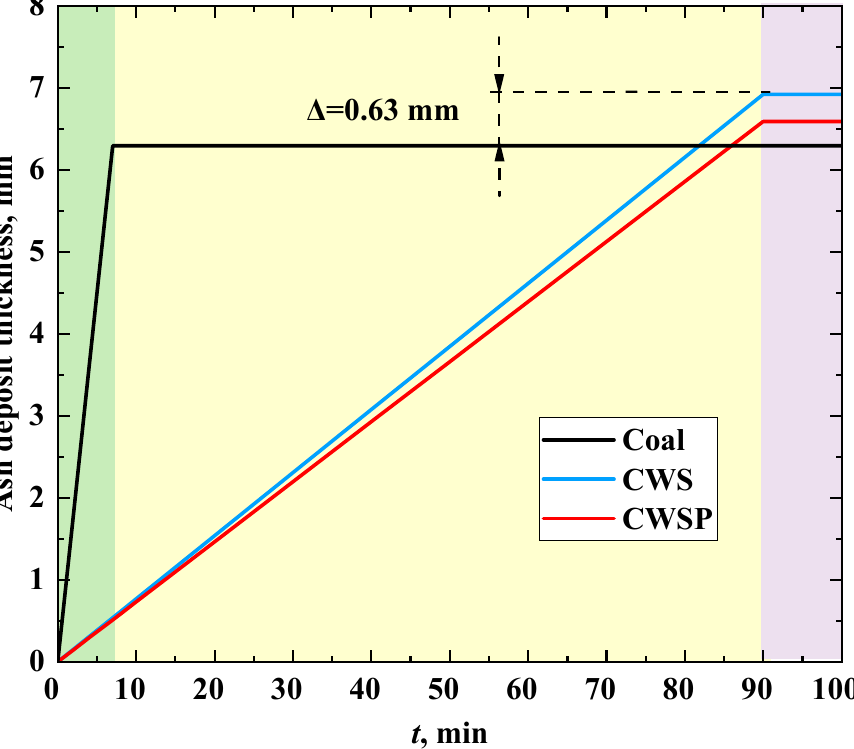
Figure 9. Typical change in the thickness of the slag layer on the surface of the heat exchanger tube when burning different fuels.